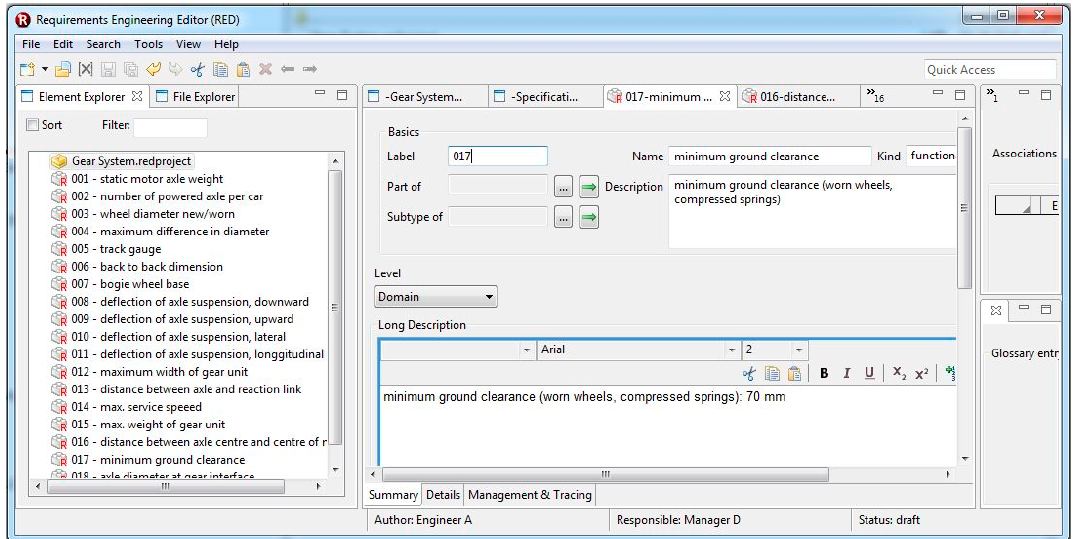
Figure 6. Requirements of a light train gear system modelled in the Requirements Editor RED.